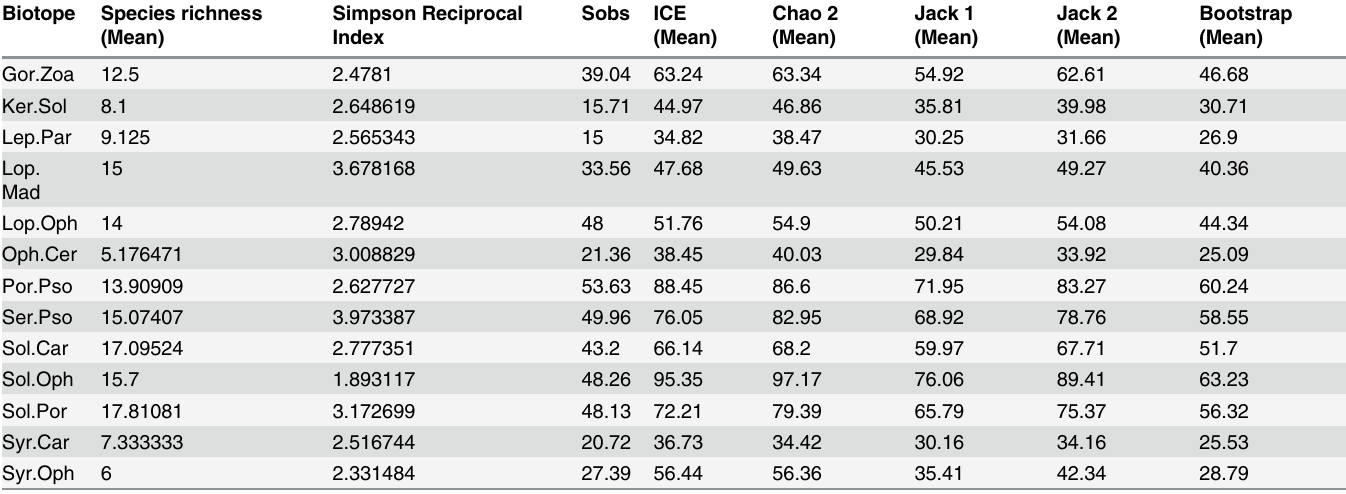
Table 3. Results of all diversity indices (mean) used in the multivariate